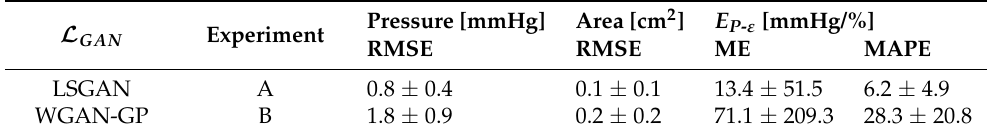
Table 3. Mean standard deviation of error for Brachial–Radial to Aortic Abdominal case on ± training